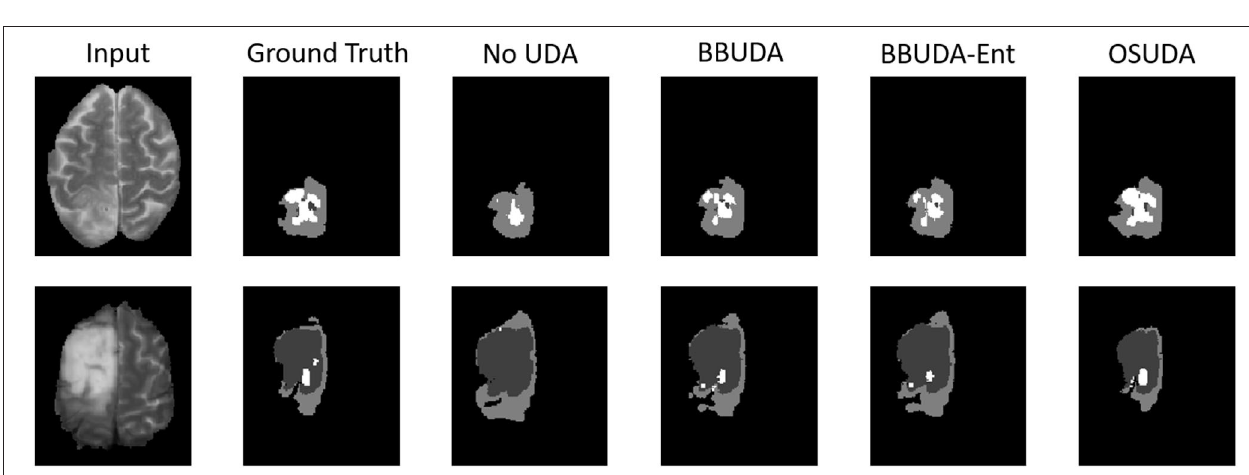
FIGURE 3 | Examples of our segmentation results from an LGG MRI slice with different methods in the HGG to LGG UDA task. In addition, BBUDA-Ent represents an ablation study of the entropy minimization. We use white, dark gray, and gray color to indicate the CoreT, EnhT, and ED, respectively. Of note, OSUDA (Liu et al., 2021k) with the white-box source model for adaptation is considered an “upper